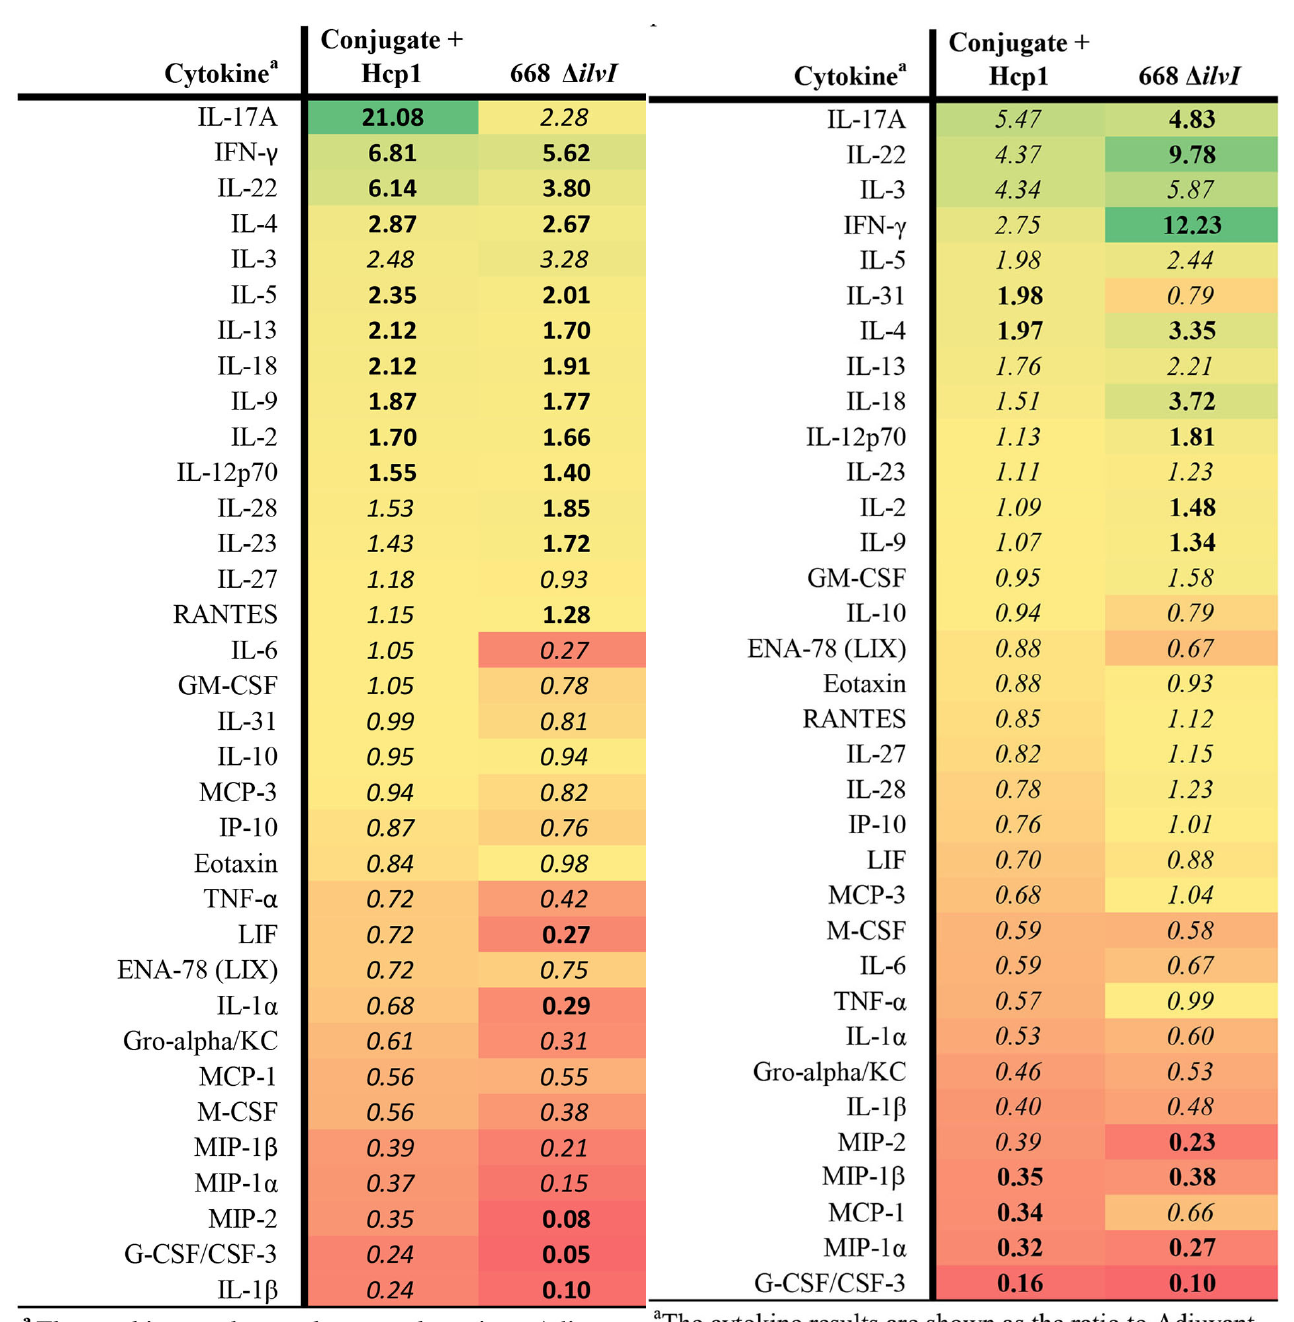
TABLE 8 Fold change on day 3 post-challenge relative to Adjuvant group of lung homogenates from vaccinated mice challenged with Bm